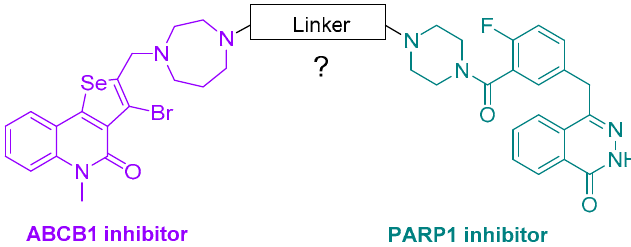
Figure 1. The structure of Olaparib conjugate with selenophenoquinolinone.